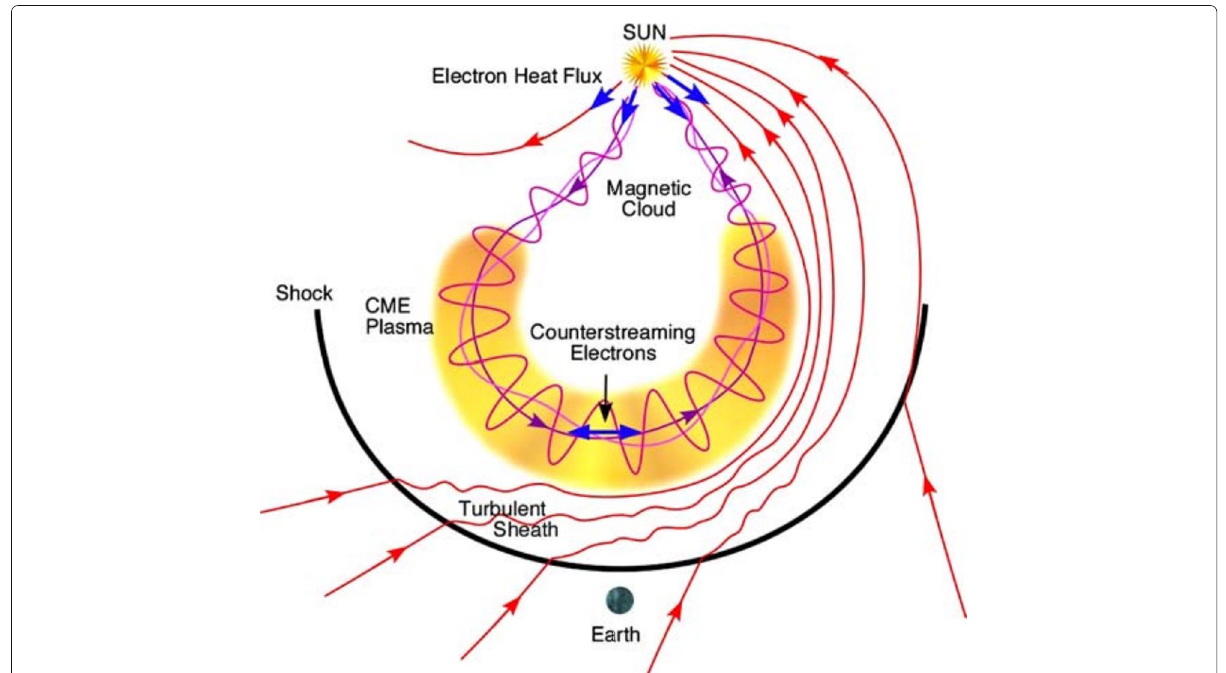
Fig. 1 A schematic illustrating the topology of a CME (reproduced from Zurbuchen and Richardson (2006)). The interplanetary shock ahead of the CME is followed by a turbulent sheath region. Closed magnetic loop lines have counter-streaming particles and may have amagnetic cloud topology